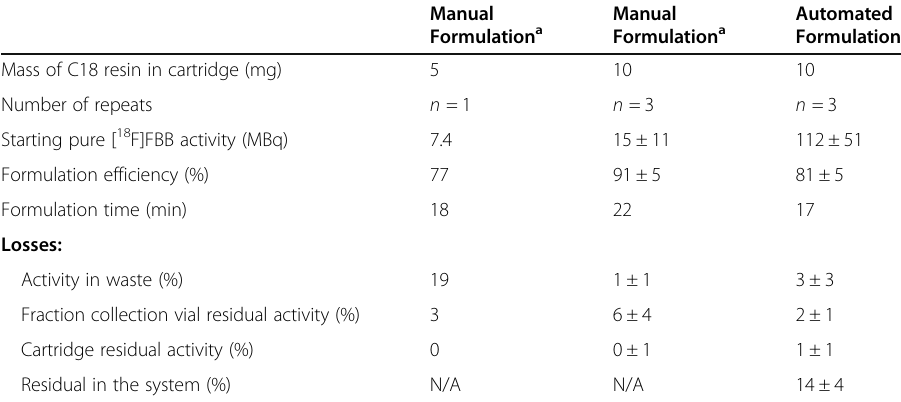
Table 2 Summary of performance of the formulation step. All % values are calculated in reference to starting pure [ 18 F]FBB activity